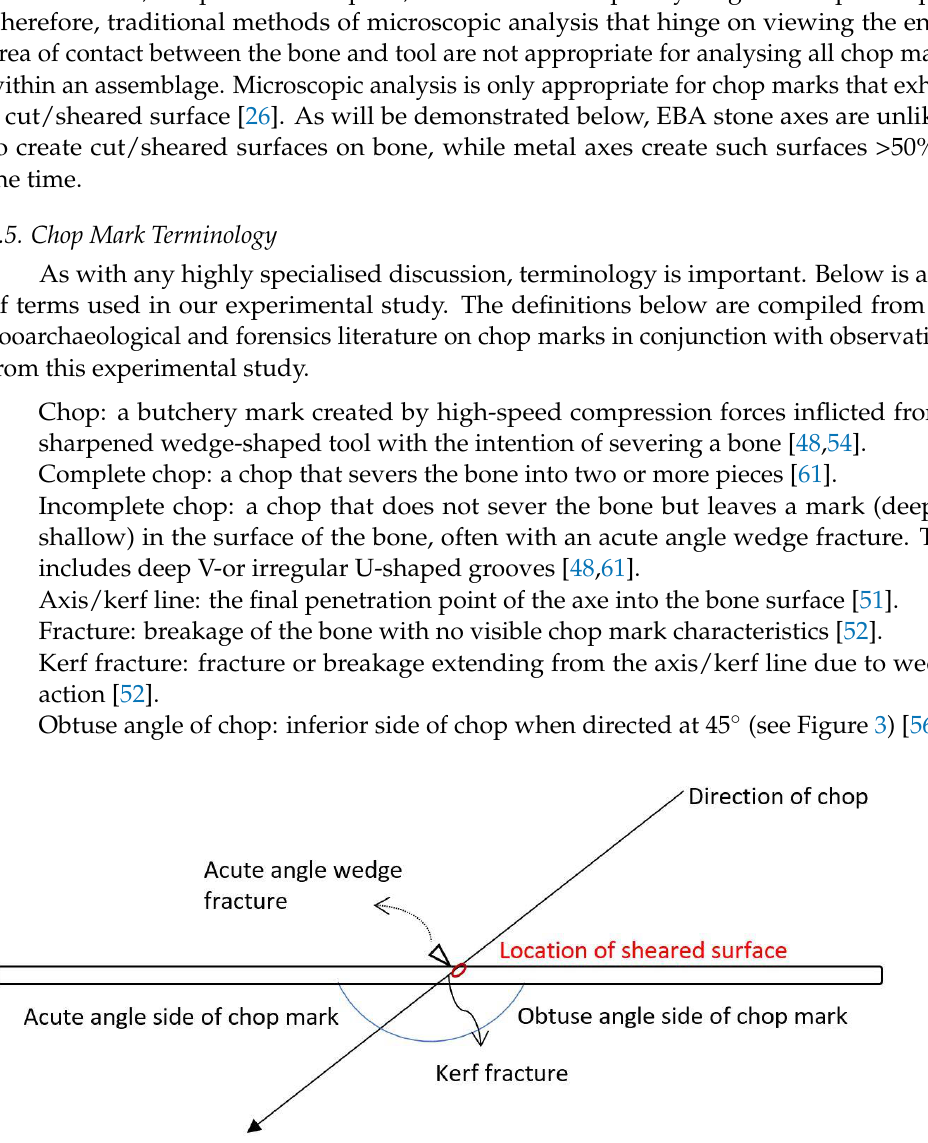
Figure 3. Schematic of chop mark characteristics based on [56].